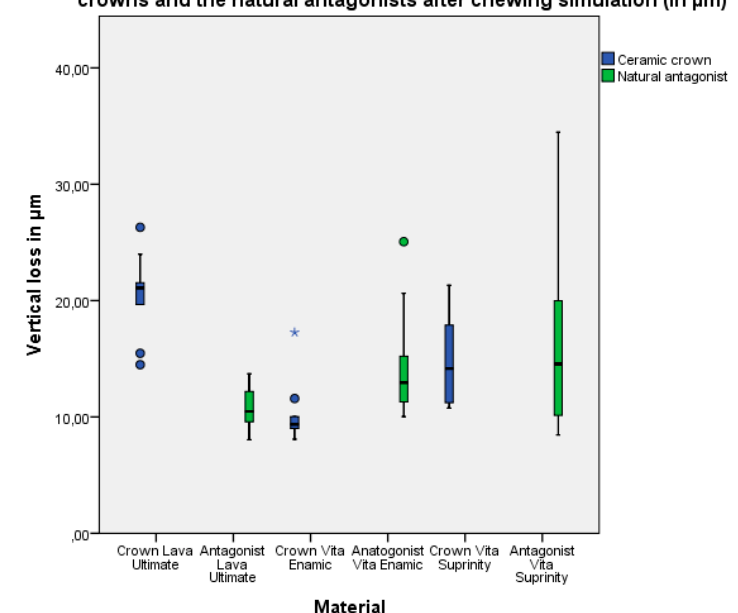
Figure 2. The main abraded cusp wear (vertical loss) of the full ceramic CAD/CAM molar crowns and the natural antagonists after chewing simulation (in μ m).